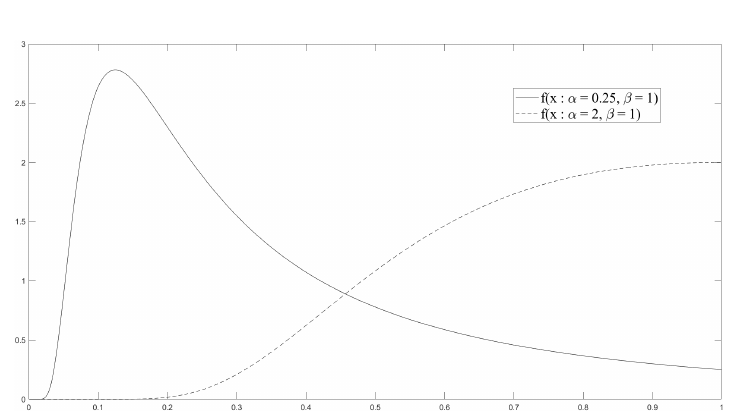
Figure 1 – Density functions of unit-Gompertz distribution for ( α = 0.25, β = 1 ) & ( α = 2, β = 1 )